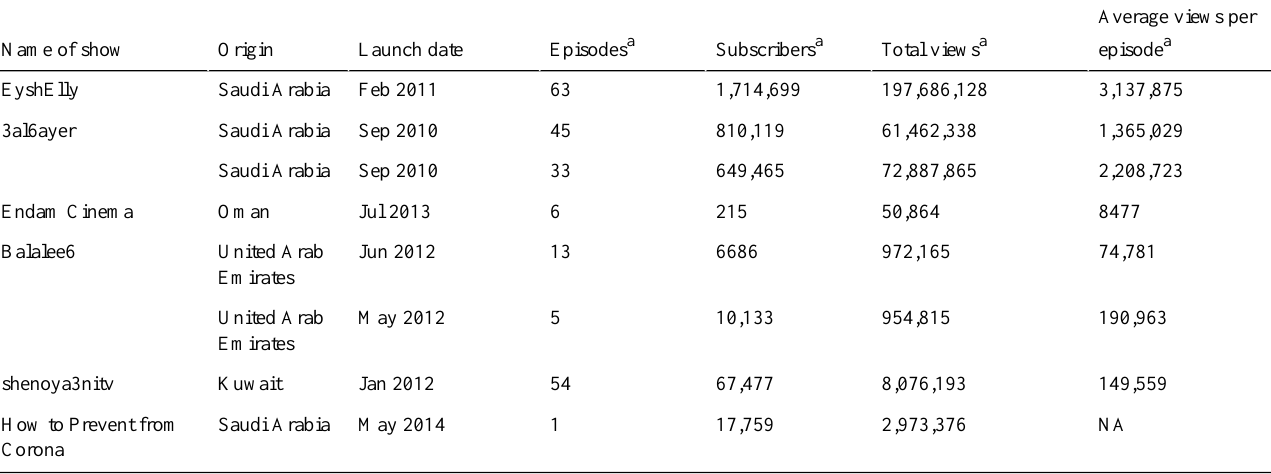
Table 3. The popularity of selected YouTube-based shows in the GCC states.